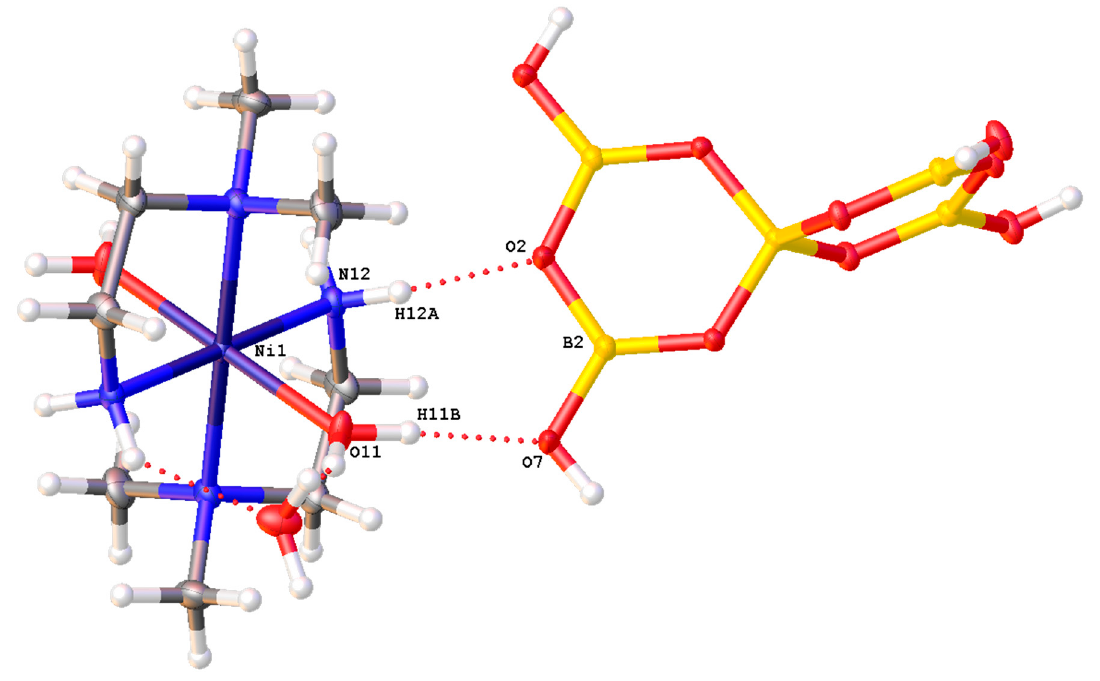
Figure 7. Drawing of the R 22 (8) {Ni1-O11-H11B ... O7-B2-O2 ... H12A-N12-} interaction involving the Ni (II) in trans - [Ni(dmen) 2 (H 2 O) 2 ] [B 5 O 6 (OH) 4 ] 2. 2H 2 O ( 3 ).